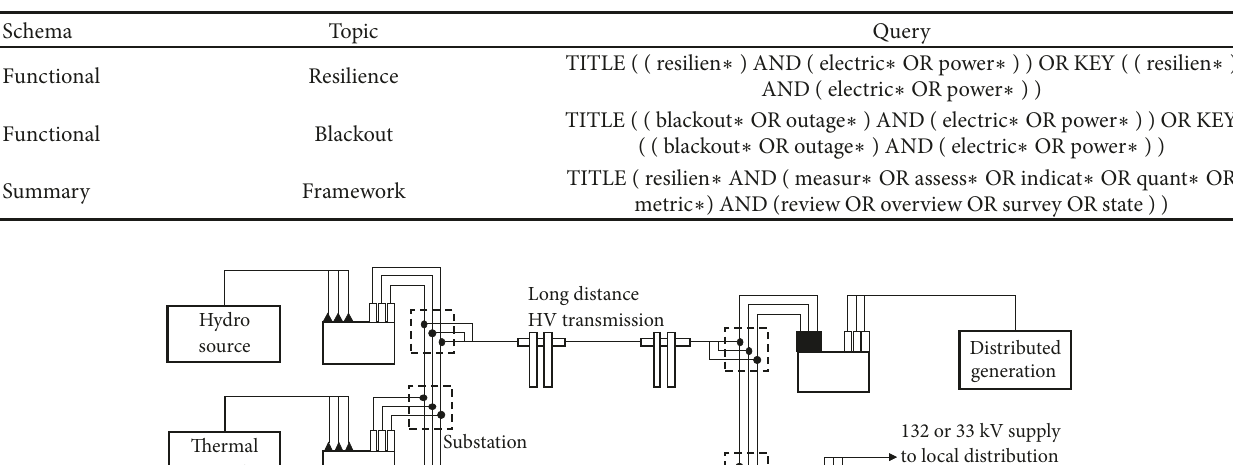
Table 1: Strings for search queries run in Scopus database.